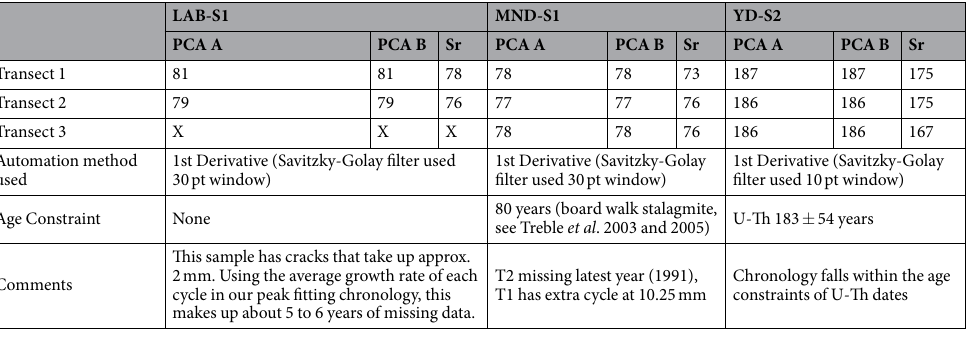
Table 2. Summary of the number of peaks identified in transects, the method used to detect the peaks, and the age constraints for each